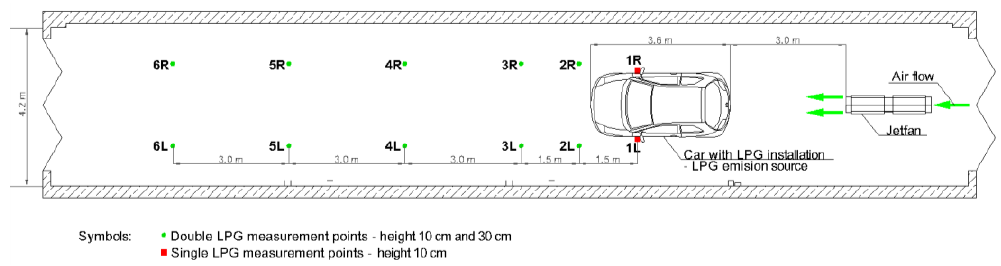
Figure 9. Plan for the spacing of the measurements during the LPG dispersion experiment.